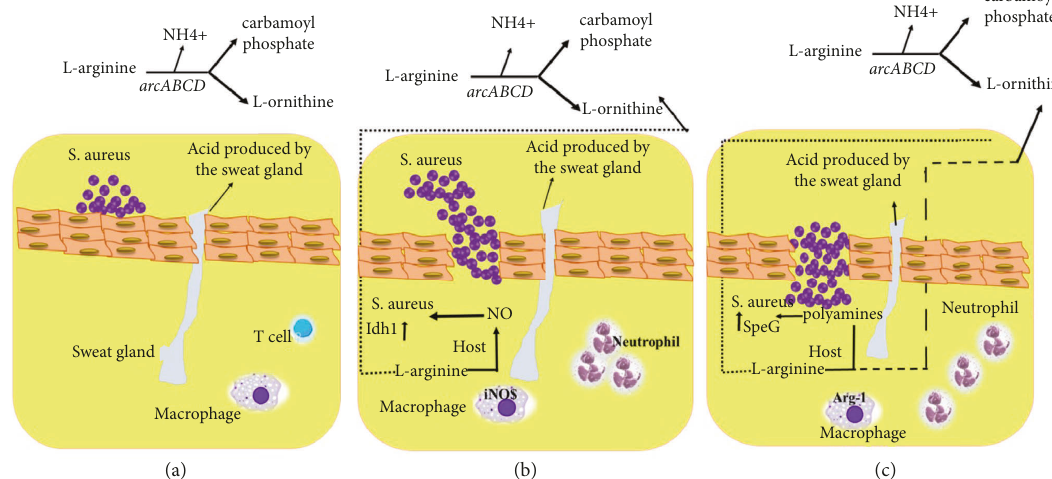
Figure 2: Schematic presentation of the role of ACME in skin survival and colonization by S. aureus USA300. (a) S. aureus neutralizes the acidic pH of sweat by producing ammonia from L-arginine catabolism and thus colonizes the skin. (b) As the upper layers of the epidermi s are broken down by bacteria, the inflammatory phase begins quickly. INOS-producing neutrophils and macrophages are presented at the site of infection. INOS produced by macrophages uses L-arginine to produce NO to kill bacteria and infection. In contrast, S. aureus counteracts this innate host attack by reregulating NO-induced lactate dehydrogenase (ldh1). (c) The infection then enters the post- inflammatory phase. At this stage, the expression of Arg-1 by host macrophages leads to the synthesis of polyamine production. As mentioned, polyamines are essential for wound healing and inflammation, and most strains of S. aureus are sensitive to it, except for strains that have the ACME-encoded speG gene. In S. aureus , L-ornithine is produced by the L-arginine arc operon and is transported to the polyamine synthesis pathway, thereby highlighting the role of the speG gene in the organism’s